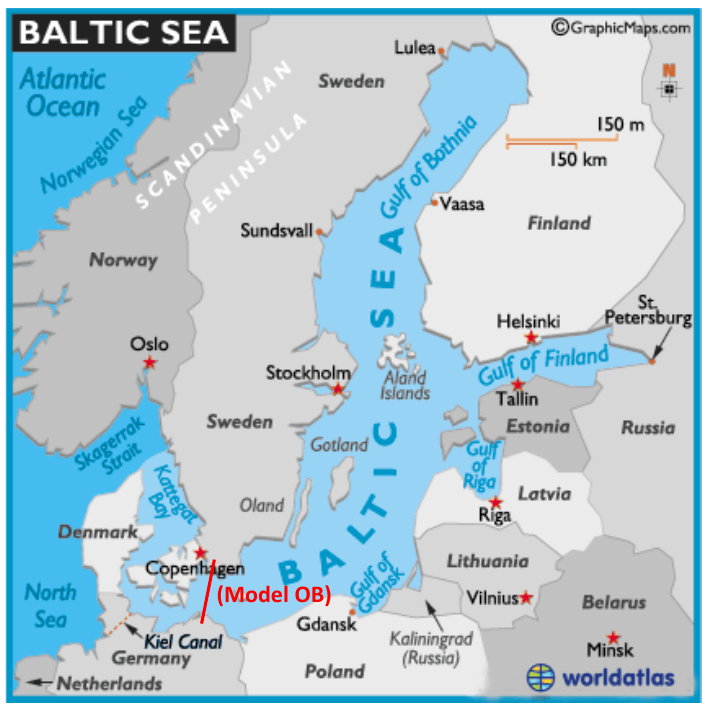
Figure 1. The Baltic model region and the model open boundary location [1].